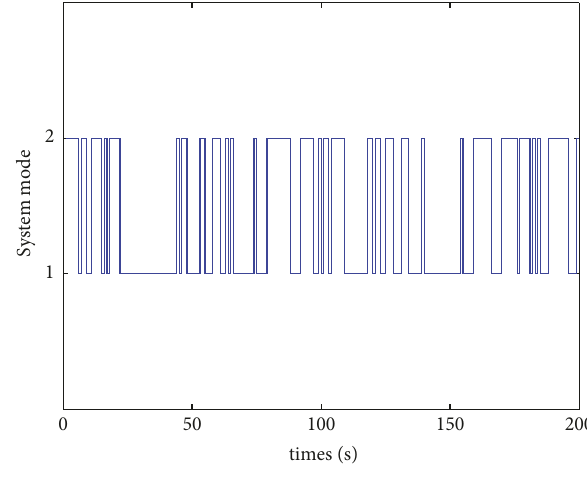
Figure 4: The switching between two modes.